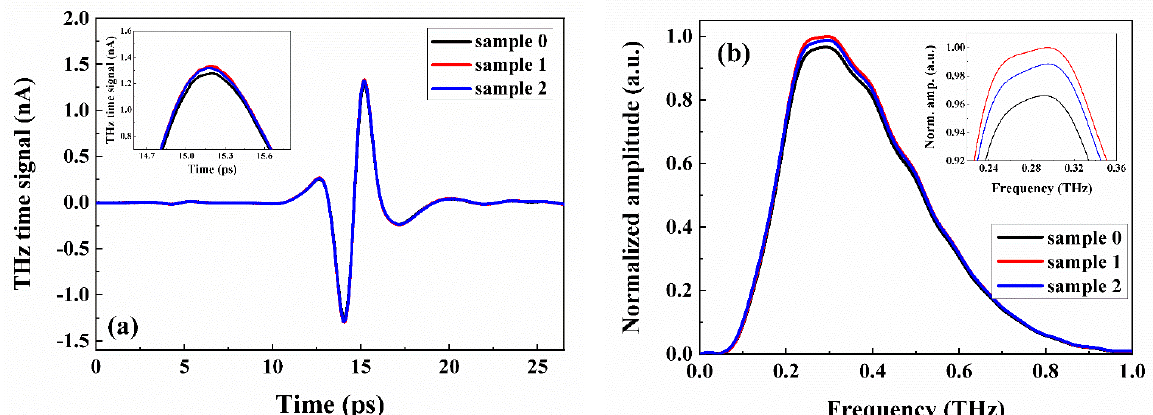
Figure 3. ( a ) The transmitted THz time-domain waveforms of CIGS films by using the THz time-domain spectroscopy and ( b ) frequency domain waveforms of time-domain waveforms.